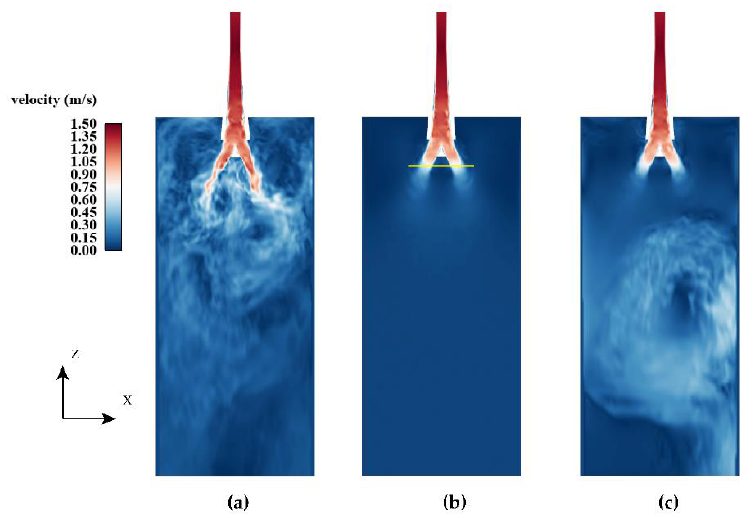
Figure 9. Contours of velocity magnitude in the wide face mid-plane: ( a ) Case A; ( b ) Case B; ( c ) Case C. A 0.4 meters long yellow line, located between the nozzle bottom and the EMBr centerline, was selected to monitor the instantaneous velocity distribution under three cases.